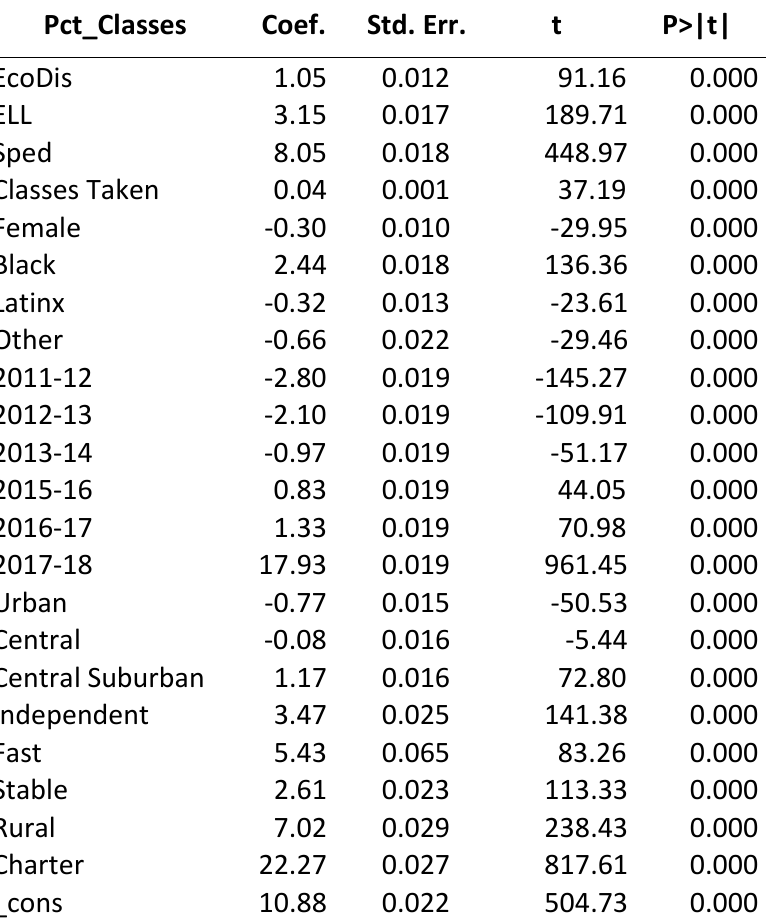
Table 3: Regression Results for Percentage of Classes Taken Out-of-Field by Student and Campus